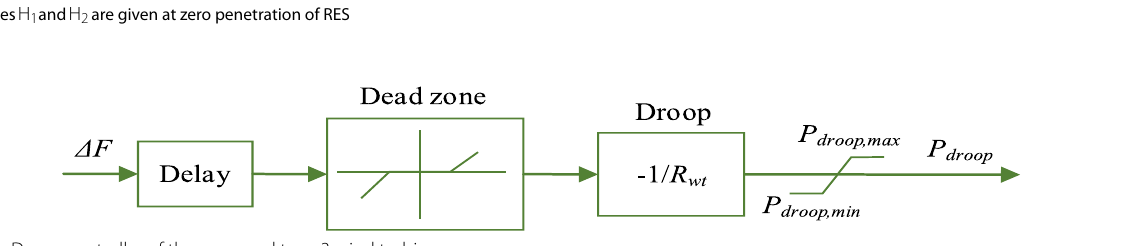
The values H 1 and H 2 are given at zero penetration of RES